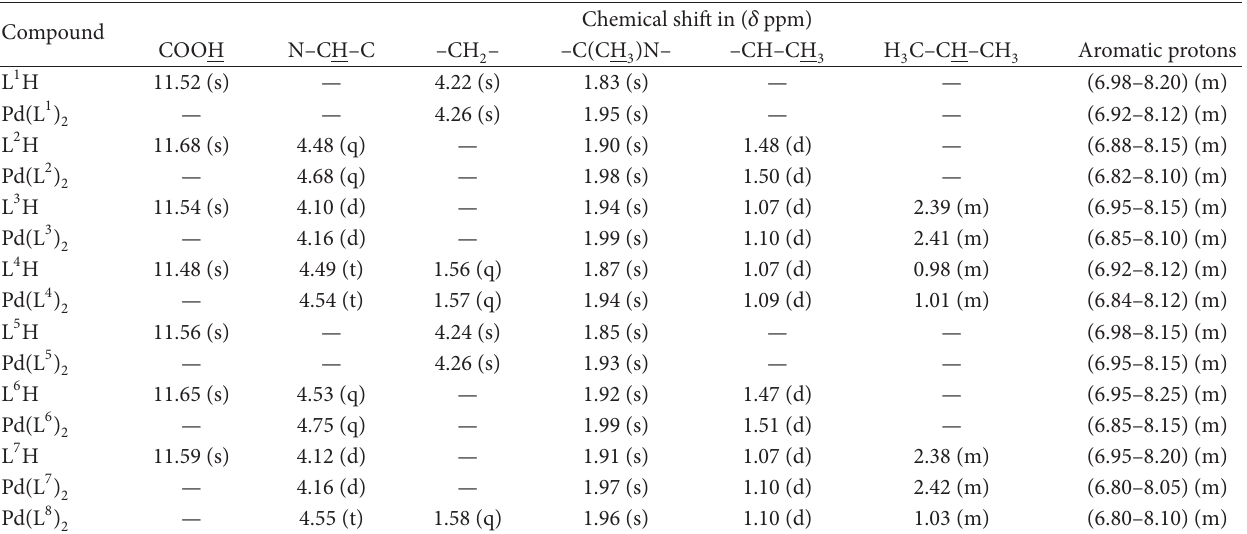
T 6: 1 H NMR spectral data of the ligands and their corresponding Pd(II) complexes.